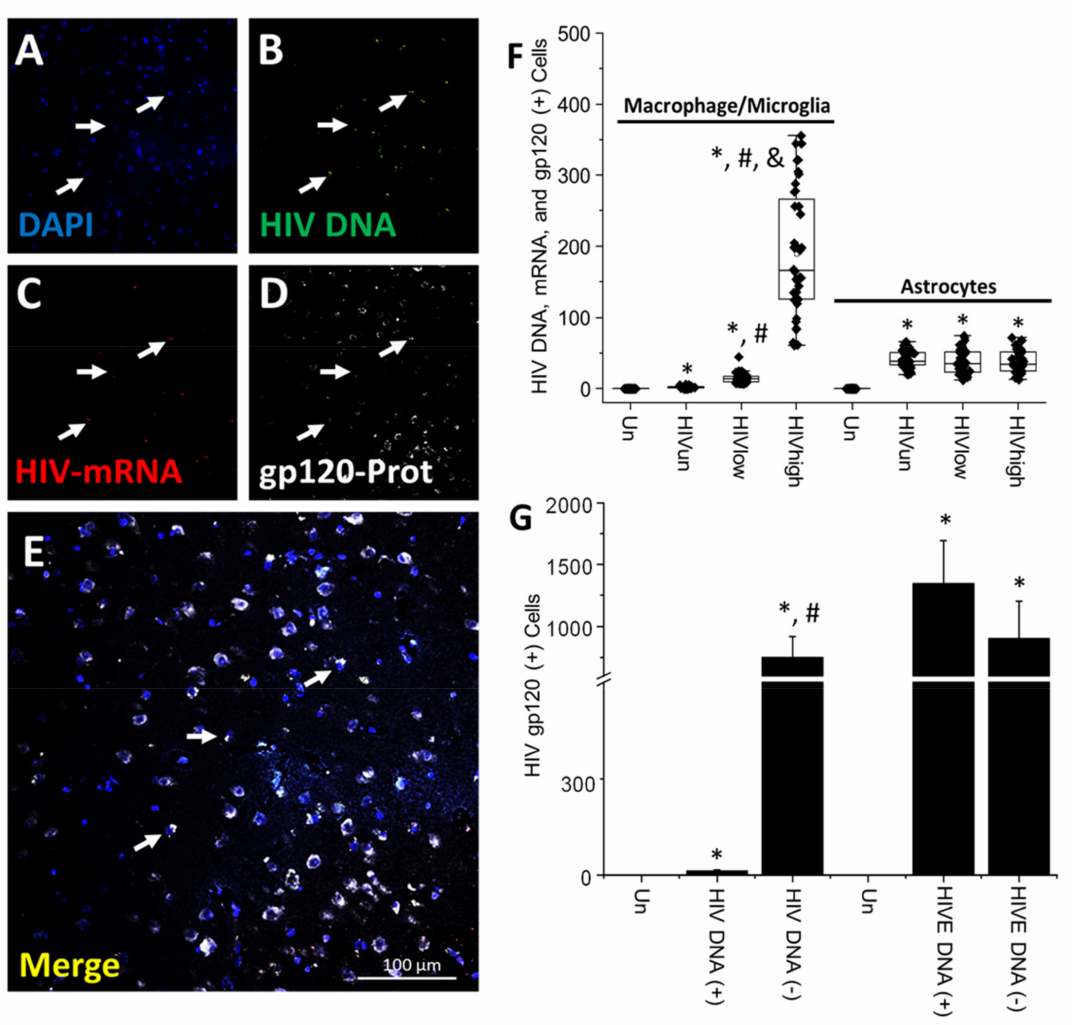
Figure 3. HIV-gp120 protein is expressed in myeloid and glial viral reservoirs and surrounding un- infected cells: potential bystander toxicity under the current ART era. ( A – E ) Representative confocal images showing ( A ) DAPI staining, ( B ) HIV DNA, ( C ) Macrophage/Microglia marker Iba-1 protein, ( D ) HIV-gp120 protein (arrows denote triple-positive cells), and ( E ) corresponds to the merging of all colors. ( F ) Quantified Macrophage/Microglia and astrocyte cells with integrated HIV DNA, producing HIV-mRNA and HIV-gp120 according to the viral replication status, including undetectable, low, and high replication (* p ≤ 0.005 compared to uninfected conditions, # p ≤ 0.005 compared to HIV un condi- tions, and & p ≤ 0.005 compared to HIV un or HIV low conditions; n = 34 tissues analyzed and 21 tissues compared to uninfected tissues, Un and Alz, n = 8 different tissues; each point represents 3–5 different areas per tissue analyzed). HIVE total numbers were 1364 ± 279 cells, 876 ± 458 for macrophages, and 624 ± 287 for astrocytes under HIVE conditions (data not plotted). ( G ) Quantification of cells positive for HIV-gp120 detected in uninfected cells (HIV DNA ( − )) surrounding the clusters containing integrated HIV DNA (HIV DNA (+)) corresponded to 750.61 ± 164.85 cells, suggesting bystander damage